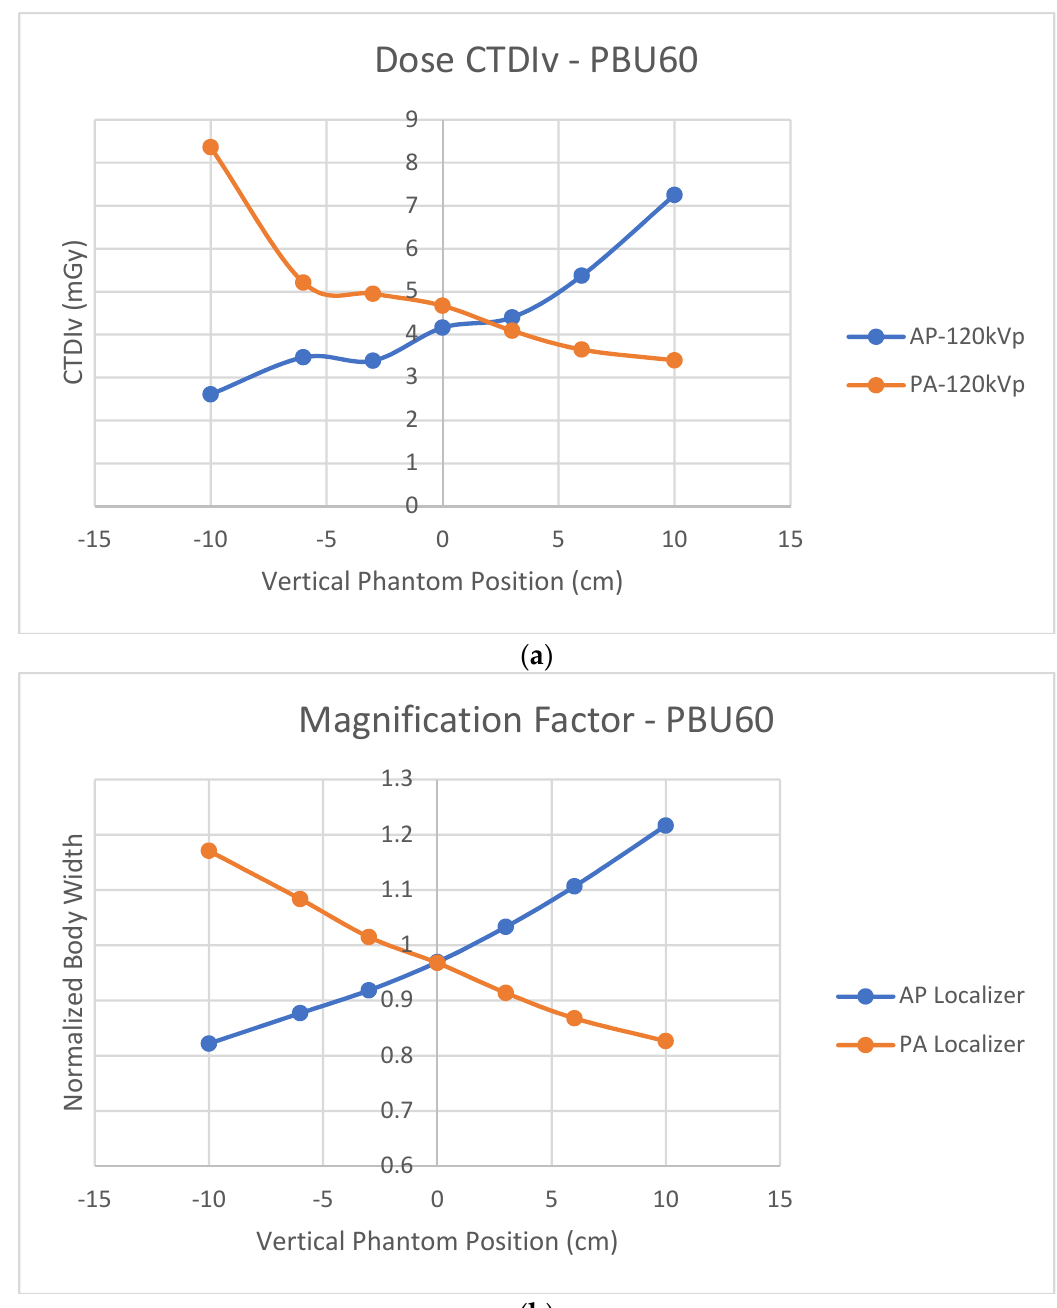
Figure 6. ( a ) Off-center dose index CTDIv variations at 120 kVp using either AP or PA localizers for the PBU60 phantom using the HD750 scanner; ( b ) the magnification factors of the measured body widths to the actual phantom width using either AP or PA localizers for the PBU60 phantom using the HD750 scanner.